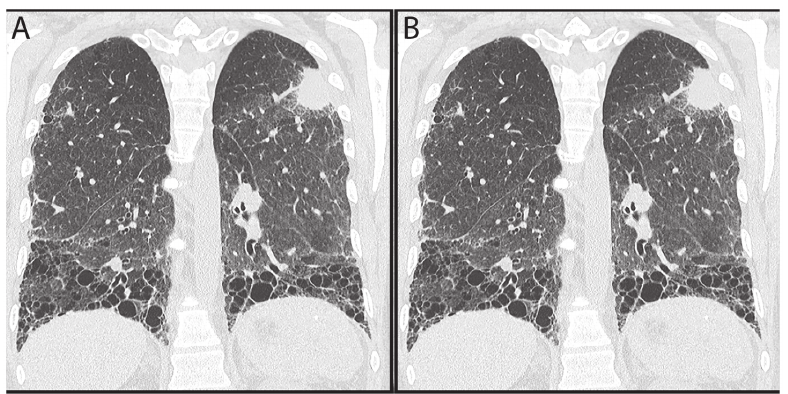
Fig 1. Computed Tomography showing (A) a left upper lobe lung mass with UIP basilar predominant fibrosis and (B) a left lower lobe consolidation (lung cancer) with NSIP.